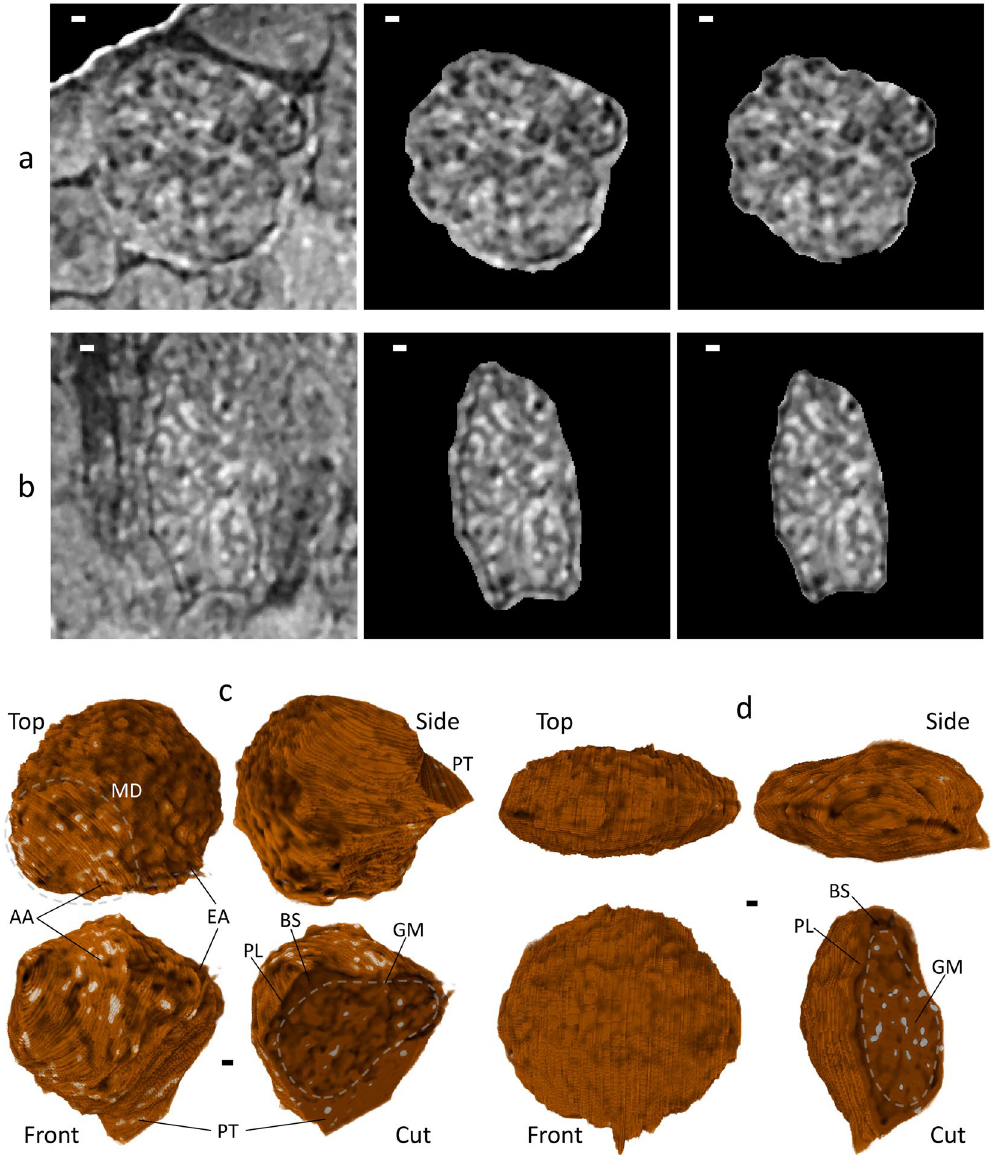
Figure 4. Segmentation and 3D rendering of renal corpuscle. Scale bars: 5 μm. Procedure of segmentation for ( a ) normal mouse (section 896th/1222) and from ( b ) disease model mouse (section 512nd/1222). The procedure is shown in chronological order: original CT slice (left), segmented renal corpuscle (center), and segmented glomerulus (right). The segmentation was performed manually using the program ImageJ 33 for each CT slice. 3D rendering of renal corpuscle from ( c ) normal mouse and from ( d ) disease model mouse. A 3D rendering model was produced from CT slices using the program Drishti 34 . Presented are three models from orthogonal perspectives (front, top, side) and a cut model from similar perspective as that of the front model. Important parts are labeled: glomerulus (GM), Bowman’s space (BS), parietal layer (PL), afferent arteriole (AA), efferent arteriole (EA), macula densa (MD), proximal tubule (PT). Some parts could not be identified for the disease model mouse. Clear, brown and white colorings indicate low-, medium-, and high-density regions, respectively. Parallel lines on the model surface are artifacts due to a technical limitation of the manual